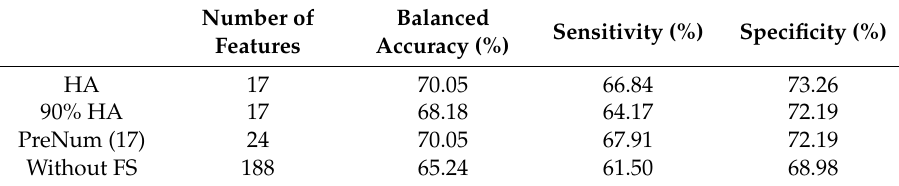
Table 3. Classification performance using three selection variants and performance without any feature selection for